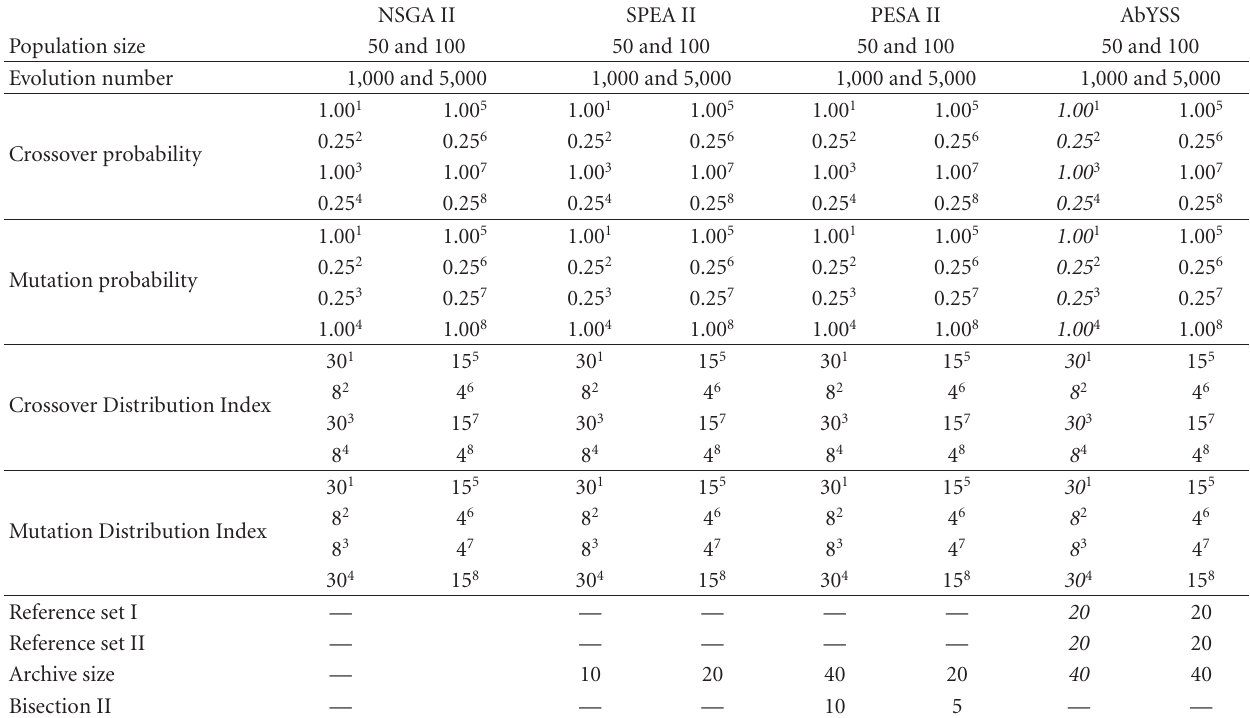
Table 1: Cases used to represent the parameter combination for evolutionary operators of MOAs and their assigned